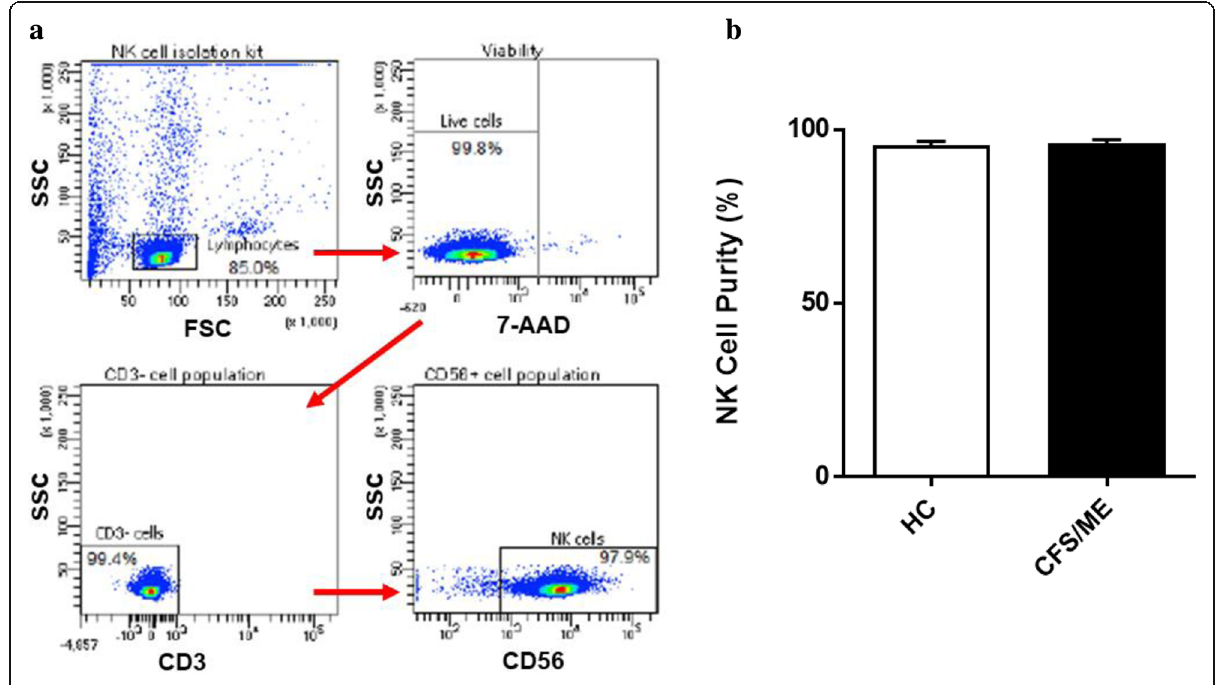
Fig. 1 Natural Killer cell purity. a Gating strategy used to identify NK cells. Representative flow cytometry plots from the PBMCs of one of the study participants. The lymphocytes were live gated during acquisition using the side and forward scatter dot plot display and then single and dead cells were excluded. Furthermore, by using the negative and positive gating strategies, CD3 − as well as CD56 + lymphocyte populations were identified. b Bar graphs representing isolated NK cell purity for HC and CFS/ME patients. Data presented as mean ± SEM. HC = 95.3% ± 1.322 and CFS/ME = 95.98%± 1.093. Abbreviations: 7-AAD, 7-amino-actinomycin; CFS/ME, chronic fatigue syndrome/myalgic encephalomyelitis; FSC, forward scatter; HC, healthy controls; NK cell, natural killer cell; SSC, side